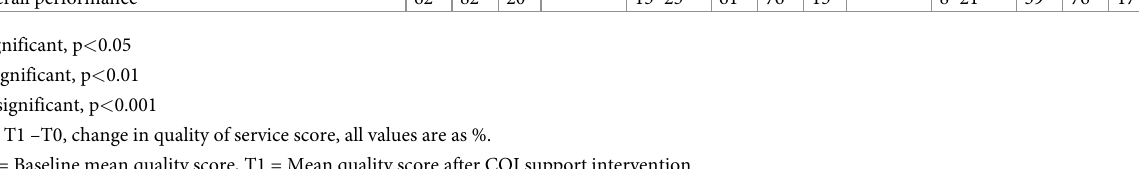
(95%CI: 34–53; p < 0.001) (Table 3). Similarly, the increases in quality of service for monitoring and evaluation of 24% in Mpumalanga (95%CI: 11–37, p < 0.001) and 29% in the Free State (Table 3). In addition, the increase in overall quality of service performance across provinces of 35% for monitoring and evaluation was statistically significant (95%CI: 28; 42; p < 0.001) (Table 2).